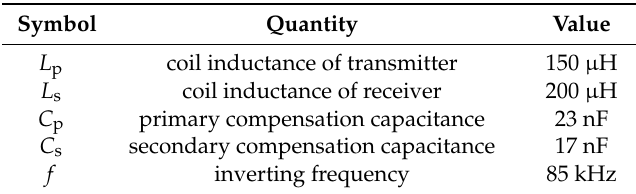
Table 1. Main parameters of WPT